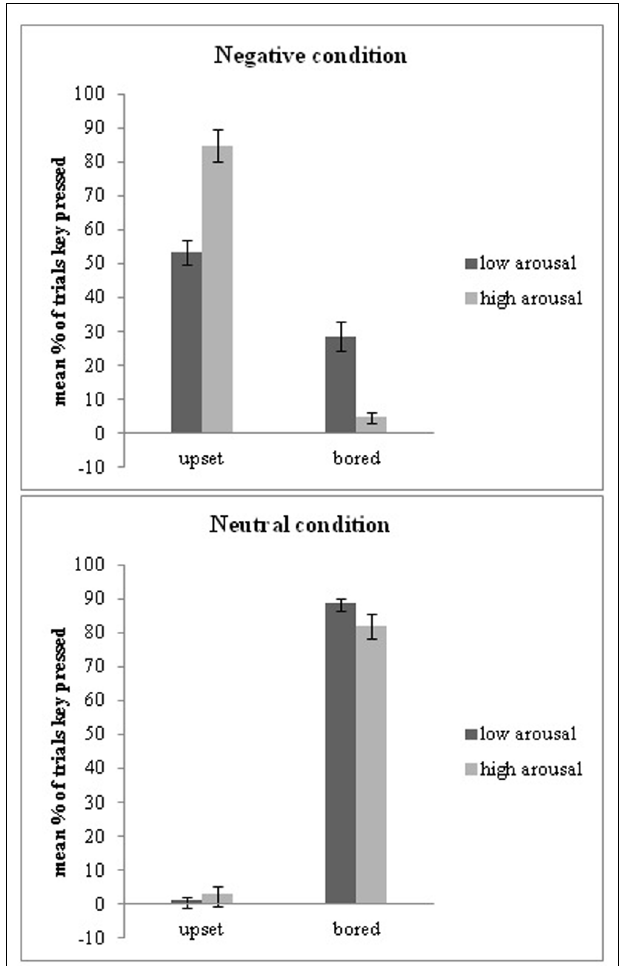
FIGURE 3 | Differences in reasons people provide for pressing the space bar are reported separately for negative and neutral pictures, with either low or high-arousal. People report being more upset by the high-arousal negative pictures, and more bored by the low-arousal both negative and neutral pictures. Error bars reflect ± 1